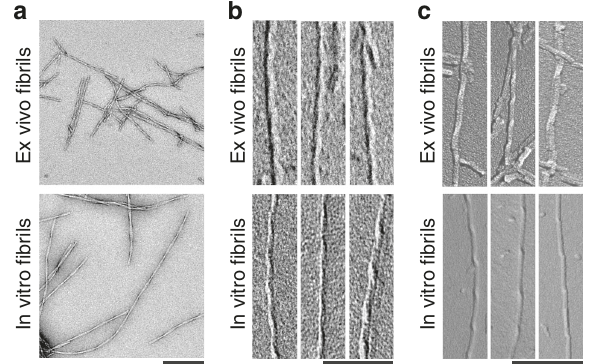
Fig. 1 Different structure of brain-derived and in vitro formed A β fi brils. a Negative stain TEM images of brain-derived amyloid fi brils or in vitro formed A β fi brils. Scale bar: 200 nm. b , c TEM ( b ) and SEM ( c ) images of brain-derived amyloid fi brils or in vitro formed A β fi brils after platinum side shadowing. Scale bars: 100